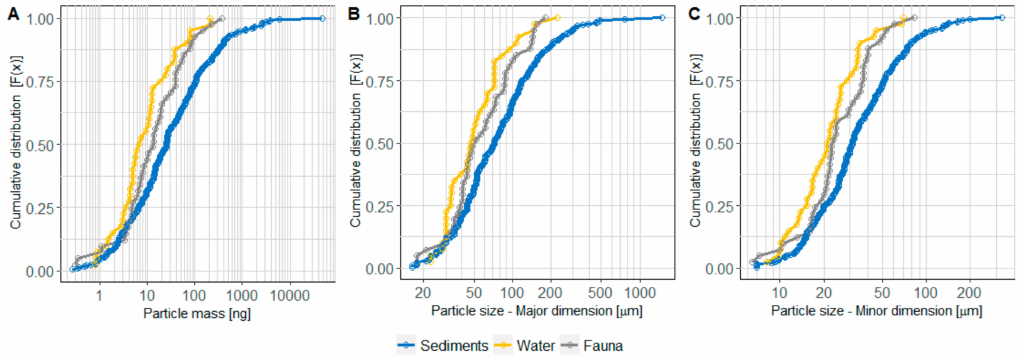
Figure 4. Cumulative distribution of the detected MP particles with respect to ( A ) summarized mass in percentage, ( B ) particle size (minor dimension) of sediment MP particles, and ( C ) particle size (minor dimension) of water and fauna MP